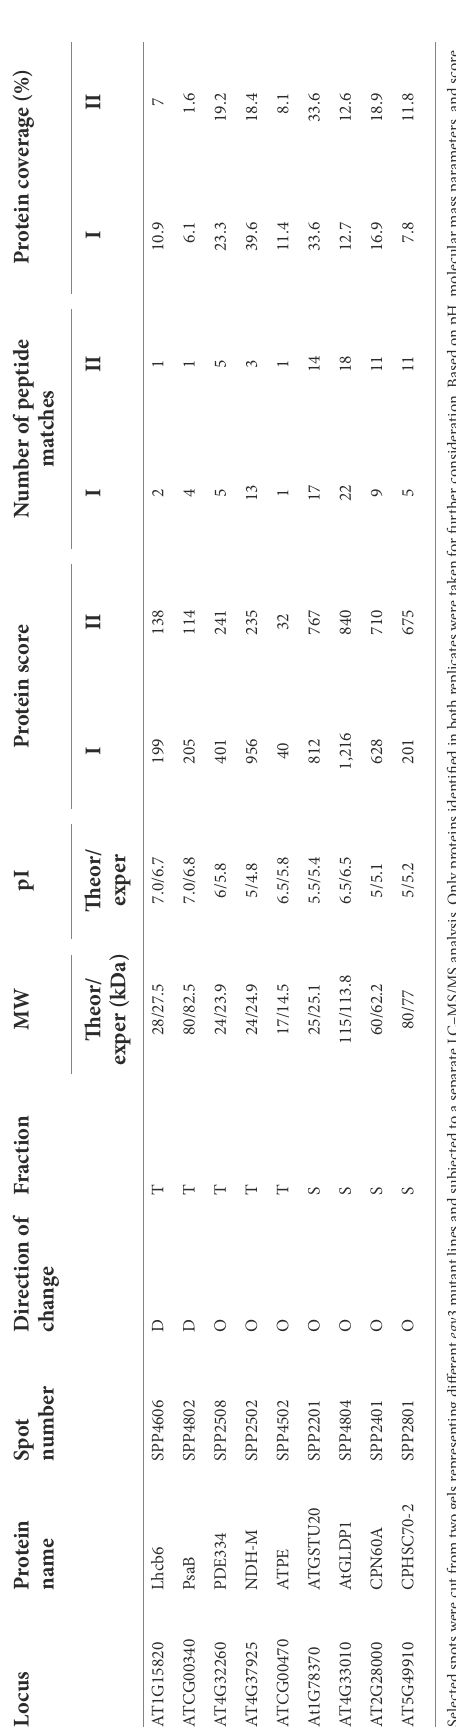
mutant lines, in the result of the 1 h exposition to the high light, observed in WT plants (Figures 9A, C). Similarly, exposure to 1 h increase in abundance of hydrogen peroxide (Figures 9B, C).